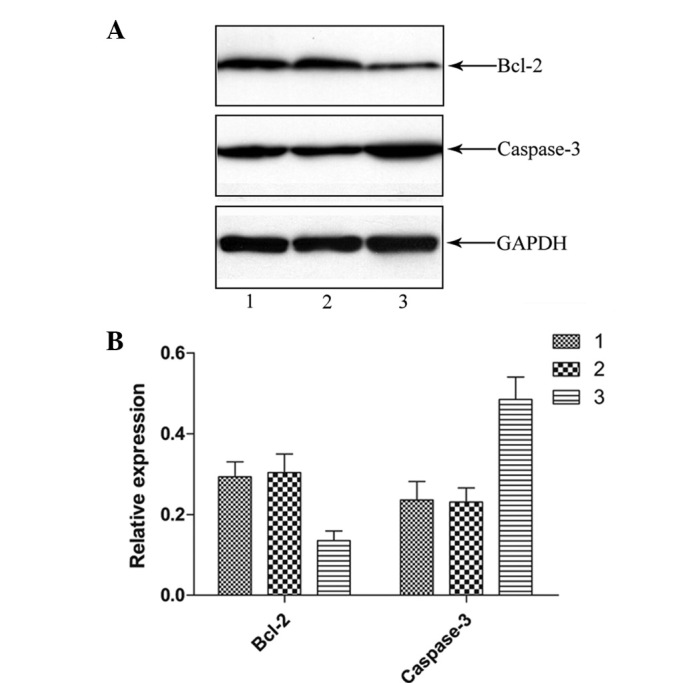
LIGHT transfection reduced caspase-3 and Bcl-2 protein levels in HCT116 cells. (A) Western blot showing caspase-3, Bcl-2 and GAPDH (loading control) staining for untreated HCT116 (lane 1), Lenti-GFP (lane 2) or Lenti-LIGHT-treated HCT116 cells (lane 3). Band signals from caspase-3 and Bcl-2 were normalized to those from GAPDH. (B) Relative expression of caspase-3 and Bcl-2 in the three groups. Lenti-LIGHT-treated HCT116 cells showed higher caspase-3 and lower Bcl-2 protein expression compared with untreated and Lenti-GFP-treated HCT116 cells (P<0.05). No difference was observed between the untreated and Lenti-GFP-treated HCT116 cells (P>0.05). LIGHT, lymphotoxin-related inducible ligand that competes for glycoprotein D binding to herpesvirus entry mediator on T cells.